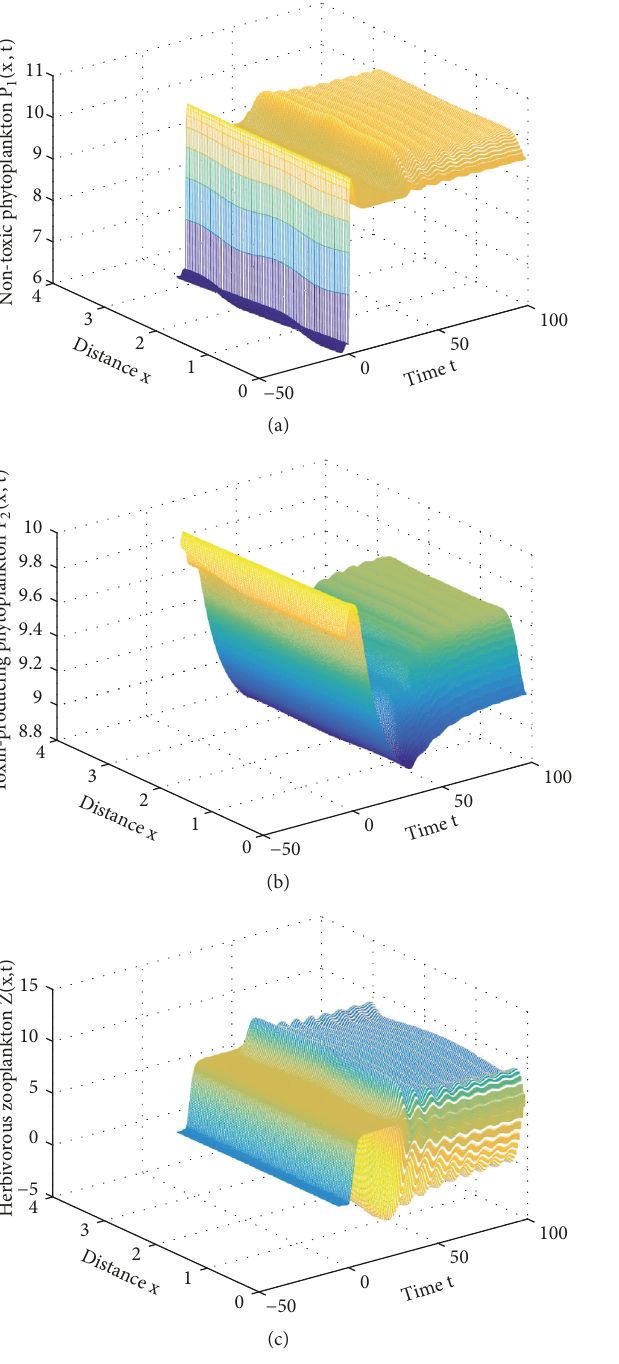
Figure 6: The spatially inhomogeneous periodic solution exists when 𝜏 = 5.42 with new coefficient values.